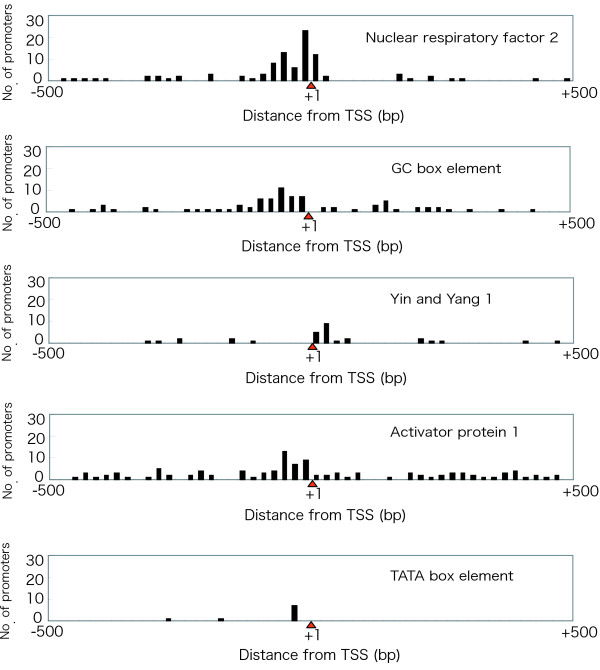
Hierarchical clustering of ribosomal protein (RP) genes by amino acid composition. The black regions represent low frequencies of encoding of the amino acid (column) by that gene (row) whereas the red regions represent high frequencies of encoding. (F: Phenylalanine, L: Leucine, I: Isoleucine, M: Methionine, V: Valine, P: Proline, T: Threonine, A: Alanine, Y: Tyrosine, H: Histidine, Q: Glutamine, N: Asparagine, K: Lysine, D: Aspartic acid, E: Glutamic acid, C: Cysteine, W: Tryptophan, R: Arginine, S: Serine, G: Glycine)